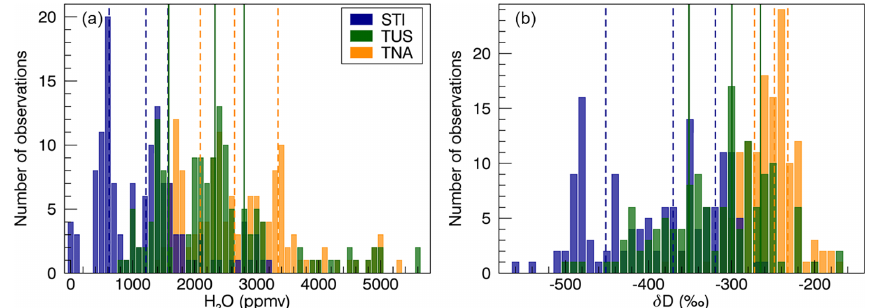
Figure 7. {H 2 O, δ D} signatures of long-range-transport events: distributions of deseasonalized (a) VMR H posphere above Zugspitze (5kma.s.l.) for stratospheric intrusions, transport from North America, and transport from northern Africa as identified in Fig. 6. Vertical lines show the median and 25th–75th-percentile range of the distributions.